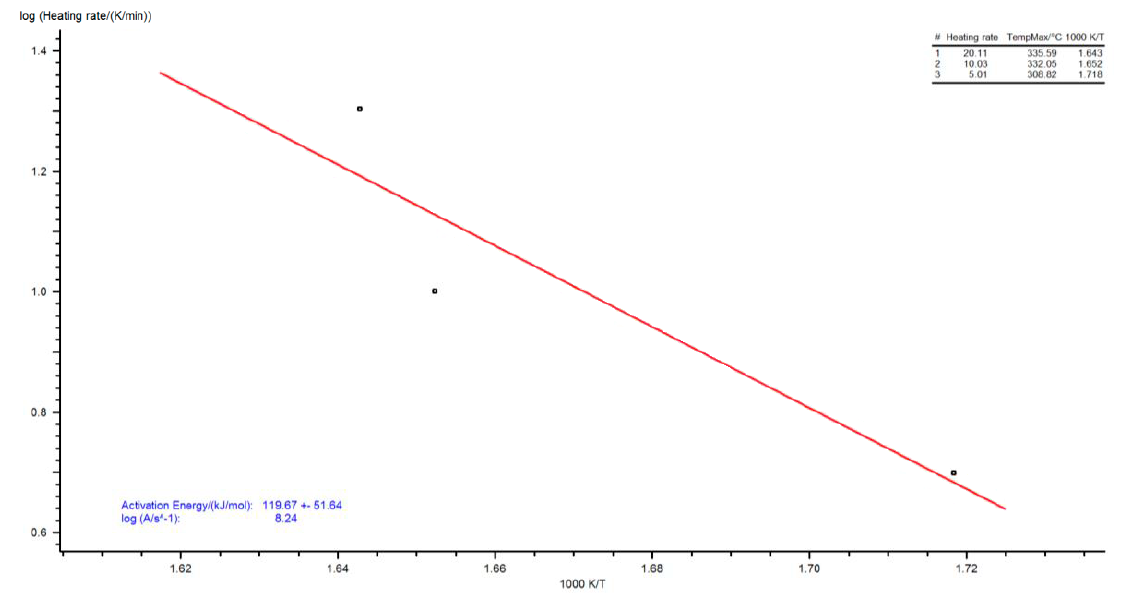
Figure A1. TG curves for three heating rates recorded for a oat straw sample.